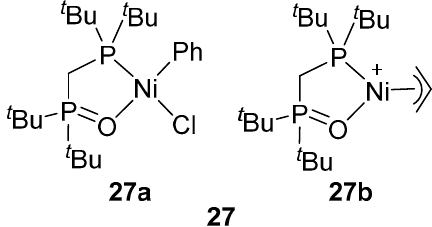
Figure 24. Methylene-bridged bisphosphine monoxide nickel catalysts 27a , b .